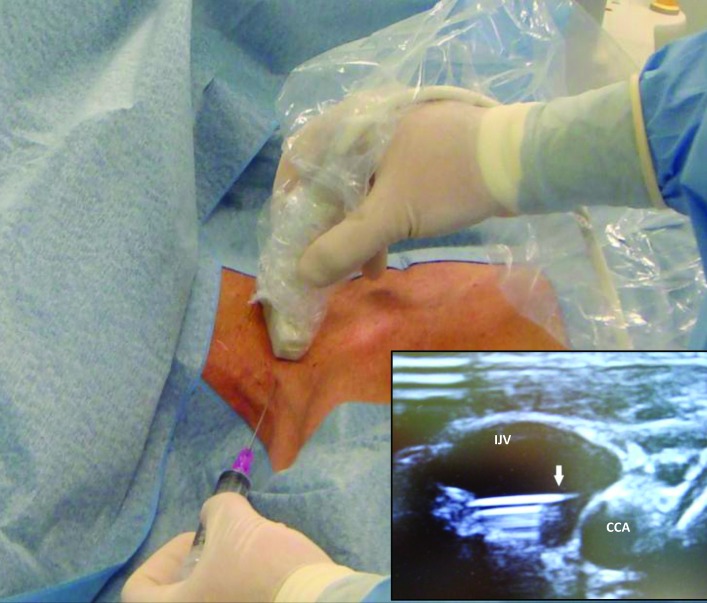
Ultrasound guided puncture posterior of the right internal jugular vein. The detail contains the ultrasonographic image of the puncture, showing the tip of the needle (arrow) inside the vein. IJV: internal jugular vein; CCA: common carotid artery.